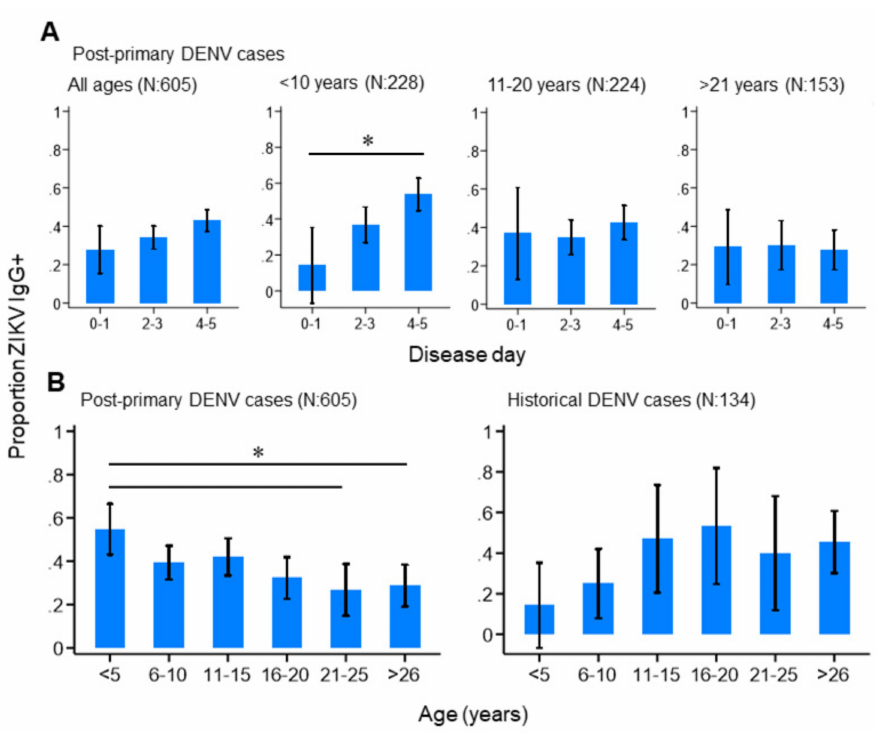
Figure 3. ZIKV IgG seroprevalence patterns among the study population. ( A ) ZIKV IgG sero- prevalence by disease day among all, and age-stratified, post-primary dengue cases. ( B ) ZIKV IgG seroprevalence among post-primary and historical dengue cases. Vertical lines: 95%CI (confidence interval), (* non-overlapping